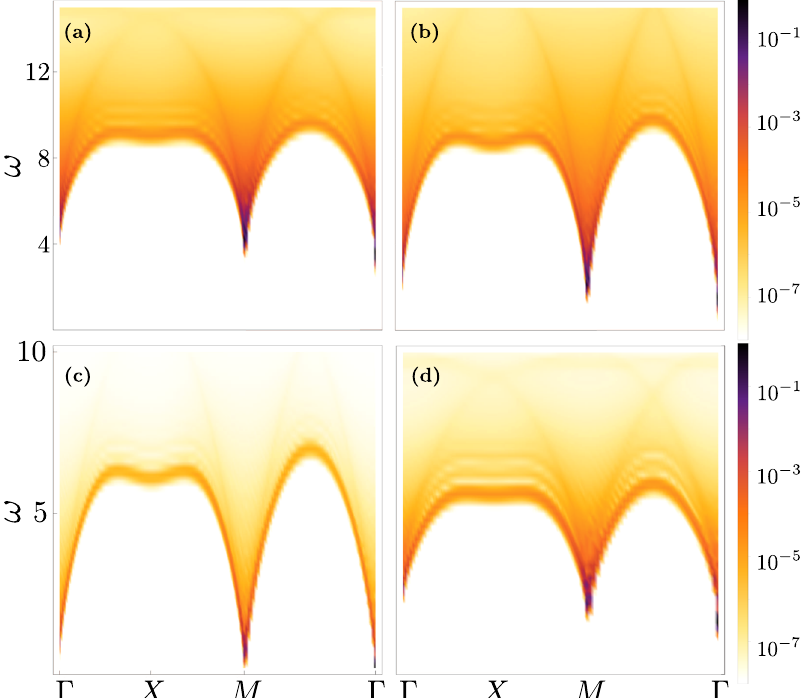
Fig. 3 Dynamical structure factor. S q ( ω ) as a function of the frequency ω and of the momentum q . Results are shown for: SL-I [panel a , γ = 9 J , α = 0.3], SL-II [panel b , γ = 9 J , α = 0.6], AFM [panel c , γ = 5 J , α = 1.0] and LRS [panel d , γ = 4.4 J , α =